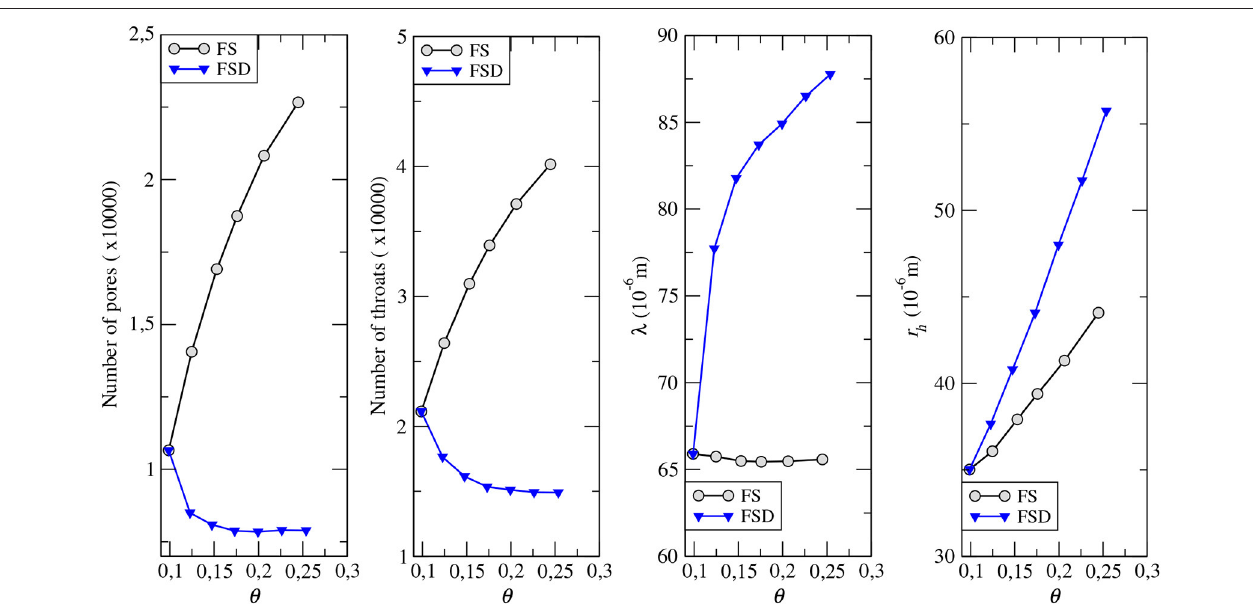
FIGURE 2 | From left to right : number of pores; number of throats; mean throat length λ ; mean throat radius r h vs. porosity θ for the FS and FSD samples.